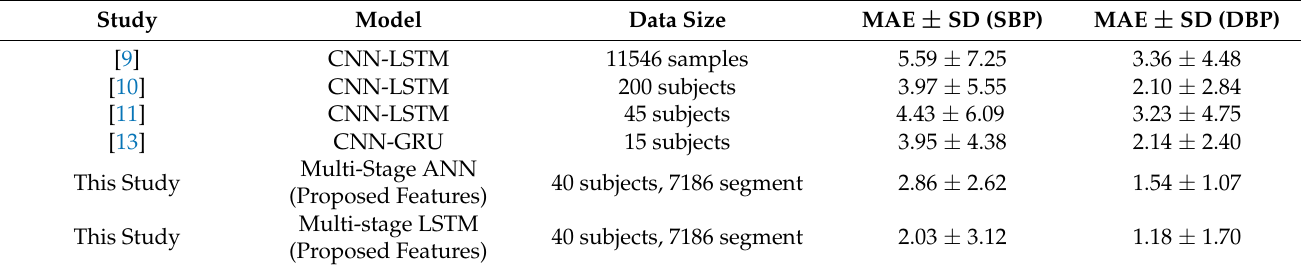
Table 9. Comparison with the State-of-art